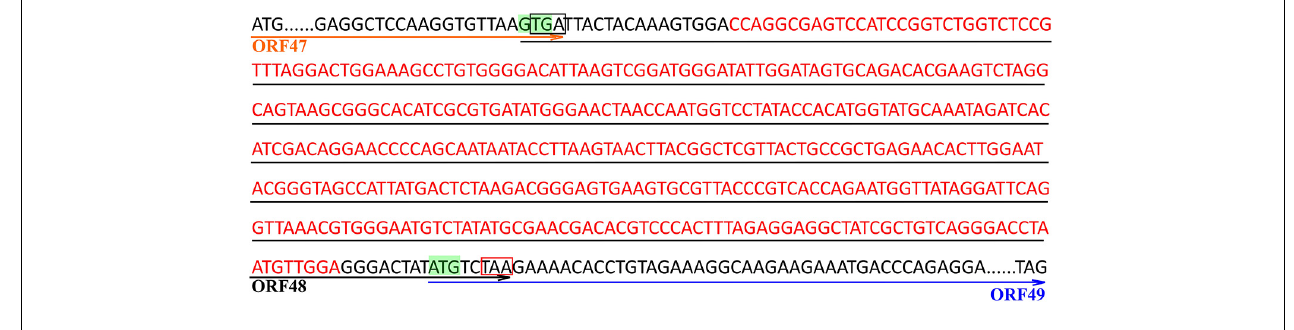
FIGURE 5 | Sequence of the inserted DNA fragment and the adjacent upstream and downstream sequences in the complete genome of Hafnia phage Ca. Red letters are the sequence of the inserted DNA fragment. Green GTG and ATG are predicted start codons of the HNH homing endonuclease gene (HEG) and the terminase large subunit gene, respectively. The sequences above the orange arrow are the predicted ORF of lysin (ORF 47). The sequences above the black arrow are the predicted ORF of HEG (ORF 48). The sequences above the blue arrow are the predicted ORF of the terminase large subunit (ORF 49). “TGA” in the black box is the stop codon of the lysin gene. “TAA” in the red box is the stop codon of HEG gene.